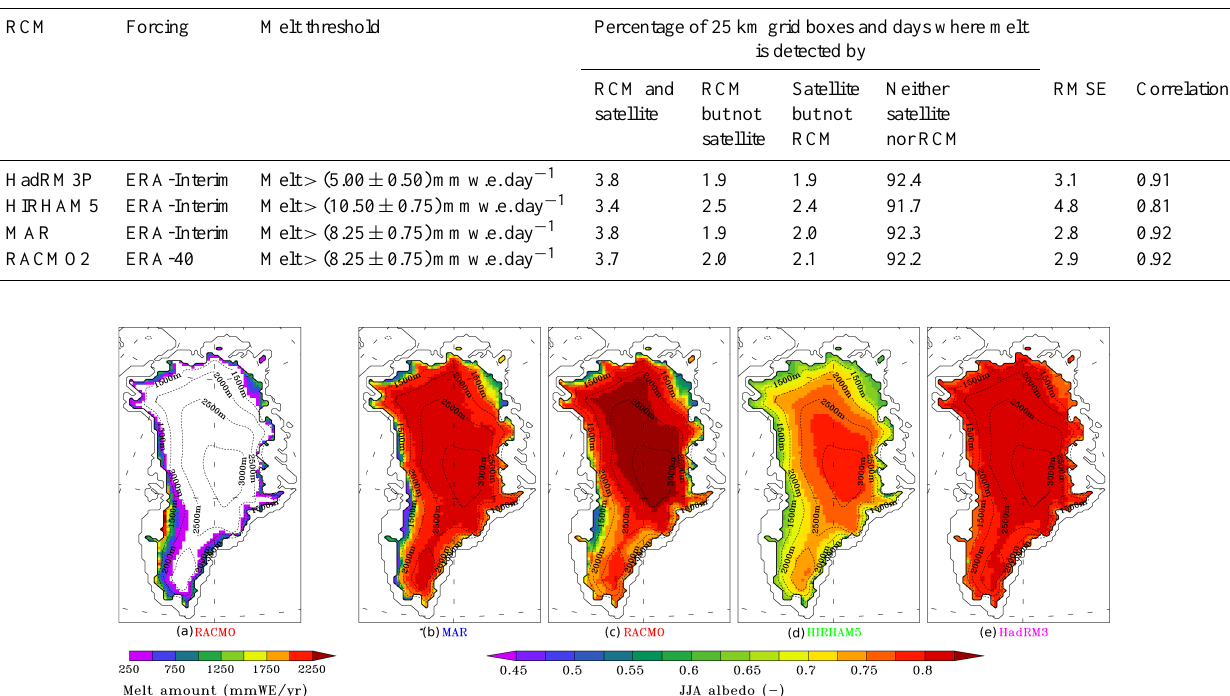
Table 2. Comparison between melt detection in satellite data and reanalysis-driven RCM output. Percentages are of the entire spatio-temporal dataset of daily data on the 25 km grid. Root mean square error (RMSE) and correlation are evaluated between the daily melt extent time series from RCM output and satellite data.